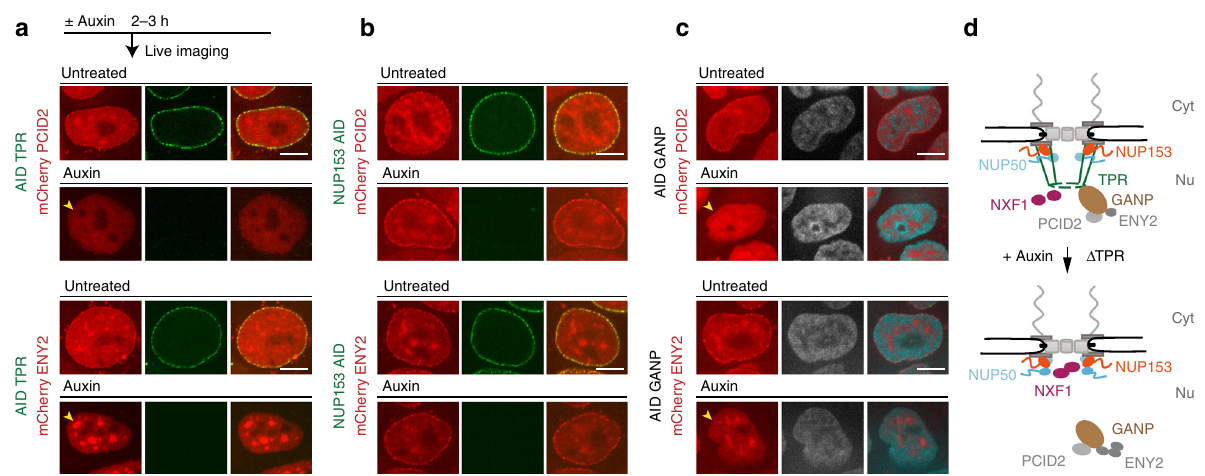
Fig. 4 TPR is required for localization of TREX-2 complex at the NPC. a – c Both TPR and GANP are required for PCID2 and ENY2 localization at the NE. Localization of mCherry-PCID2 and mCherry-ENY2 in cells after acute loss of TPR ( a ), NUP153 ( b ), or GANP ( c ). (see also Supplementary Fig. 7b, c). Note the changes in NPC localization of PCID2 and ENY2 (yellow arrowheads). Scale bar is 7 µ m. All BSK-NUPs and NXF1 AID-tagged cell lines were treated with auxin for 2 h; GANP AID-tagged cell line was treated with auxin for 3 h. Data are representative of three independent experiments. d A schematic representation of the TREX-2 – NPC